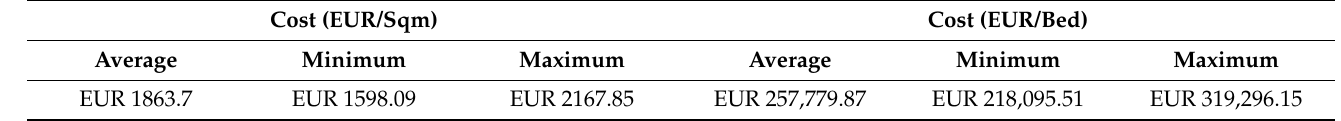
Table 4. Panel investigation construction cost output.